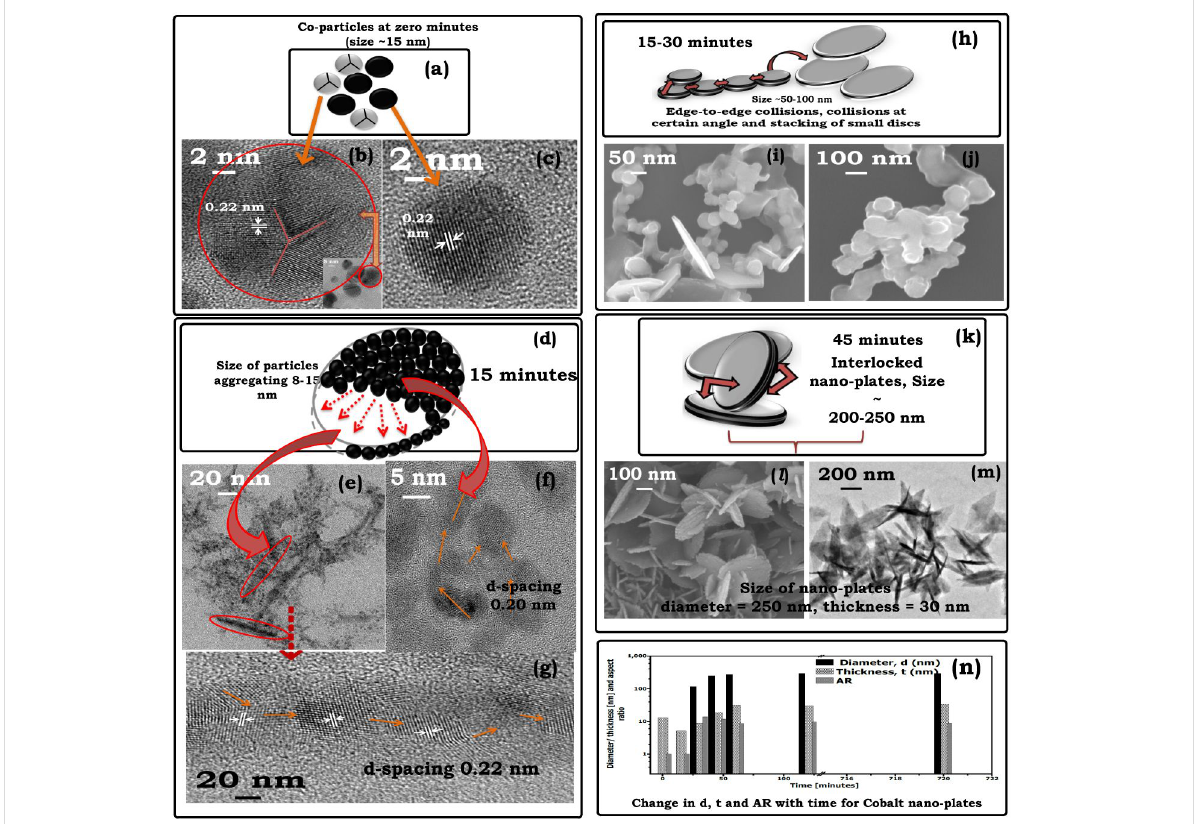
Figure 3: Schematic showing the growth of nanoplates. (a) Simultaneous presence of twinned and single- crystal nanoparticles at “zero time”; (b) high-resolution image of twinned nanoparticles; (c) high-resolution image of single-crystal nanoparticles, both observed at “zero time”; (d) the illus- tration shows how different modes of aggregation of tiny particles form the upper and side planes of the nanoplates after 15 min; the size of the nano- particles drops from 15–20 nm to 8 nm; (e,f) low- and high-resolution micrograph, showing the spread of small nanoparticles with linear aggregation; (g) Brownian-motion controlled random aggregation of nanoparticles; (h) edge-to-edge collision of small nano-discs in the transition regime; (i) FEGSEM micrograph showing edge-to-edge aggregation after 15–30 min; (j) FEGSEM micrograph showing small nano-discs in the vicinity of bigger nanoplates after 15–30 min; the time interval of 15 min marks the initiation of shape anisotropy; (k) interlocked nano-plates appear first after 45 min; (l,m) FEGSEM and FEGTEM, respectively, micrographs showing interlocked nanoplates after 45 min; (n) length, diameter and aspect ratio distribution of nanoparticles as a function of time from 0 to 120